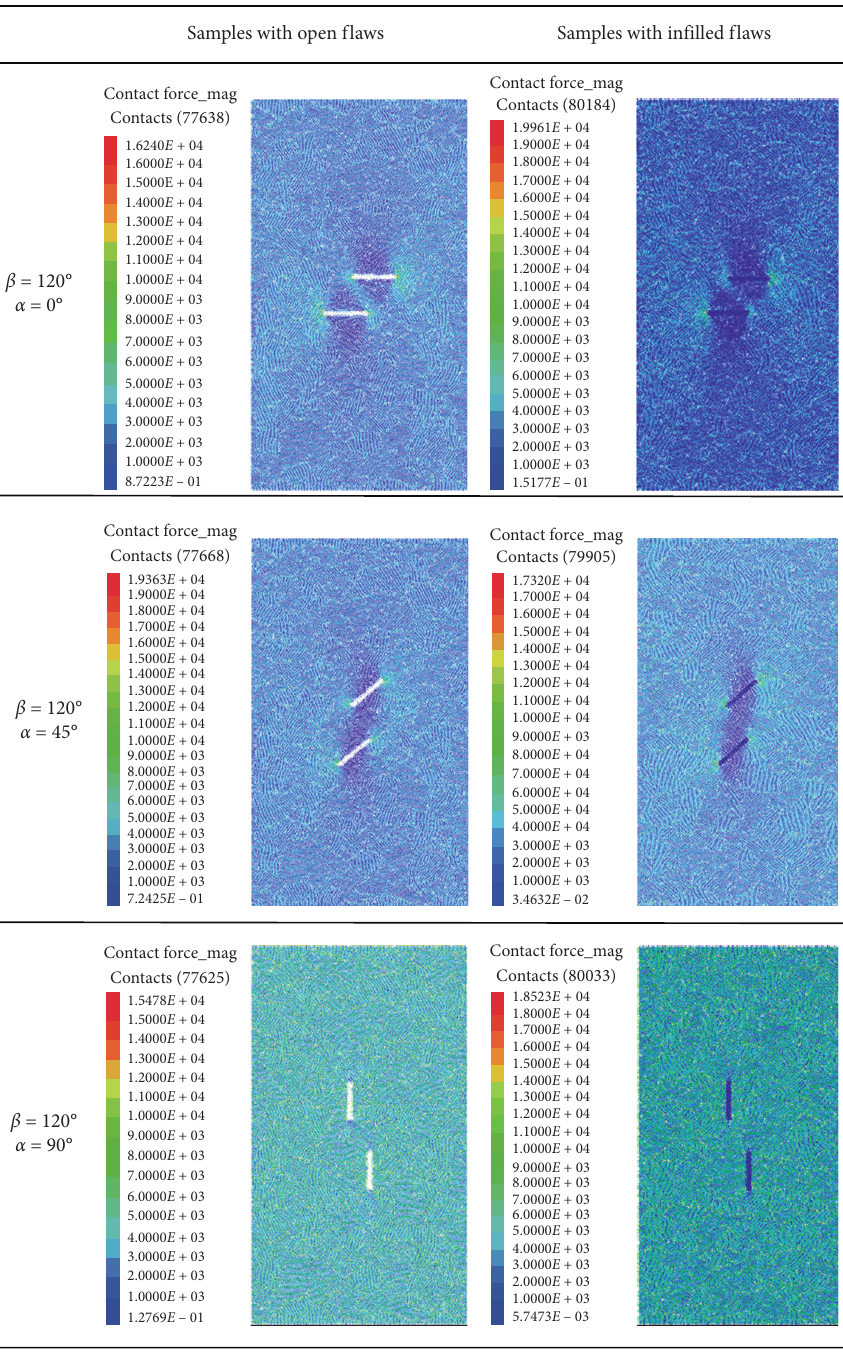
Figure 13: Contact force of samples containing open and infilled flaws with β of 120 ° and α of 0 ° , 45 ° , and 90 ° when the loading stress reaches the crack initiation